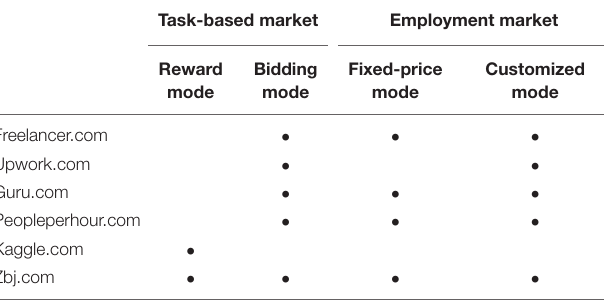
TABLE 1 | Market types of crowdsourcing